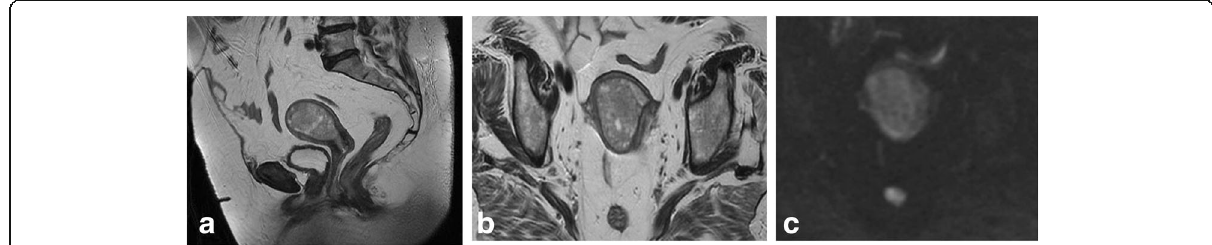
Fig. 10 Endometrial hyperplasia visualized by sagittal T2WI ( a ) and axial oblique T2WI ( b ). Both images show intracavitary endometrial proliferation that is hyperintense relative to the myometrium. In panel c , there is no diffusion restriction on b = 1000